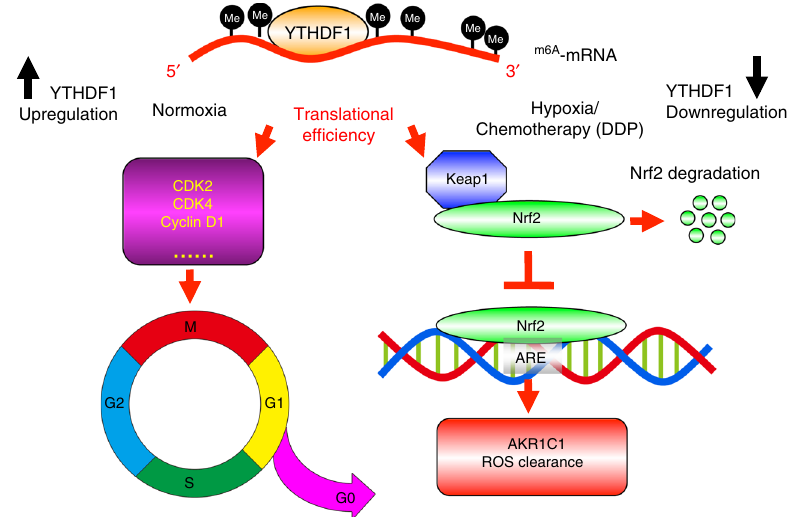
Fig. 6 A working model for YTHDF1. As proposed in this model, under normoxia conditions for NSCLC progression, YTHDF1 ampli fi cation or high expression mainly promotes the translational ef fi ciency of targeted m 6 A-modi fi ed transcripts, such as cell cycle regulators including CDK2, CDK4, cyclin D1, etc., in cancerous cells, which causes uncontrolled cancerous cell proliferation. On the other hand, when YTHDF1 low expression NSCLC patients encounter chemotherapy stress condition, especially cisplatin treatment-induced reactive oxygen species (ROS) accumulation, decreased Keap1 translational ef fi ciency leads to upregulation of Nrf2 and its downstream ARE responding factor antioxidant AKR1C1, which in turn renders cancerous